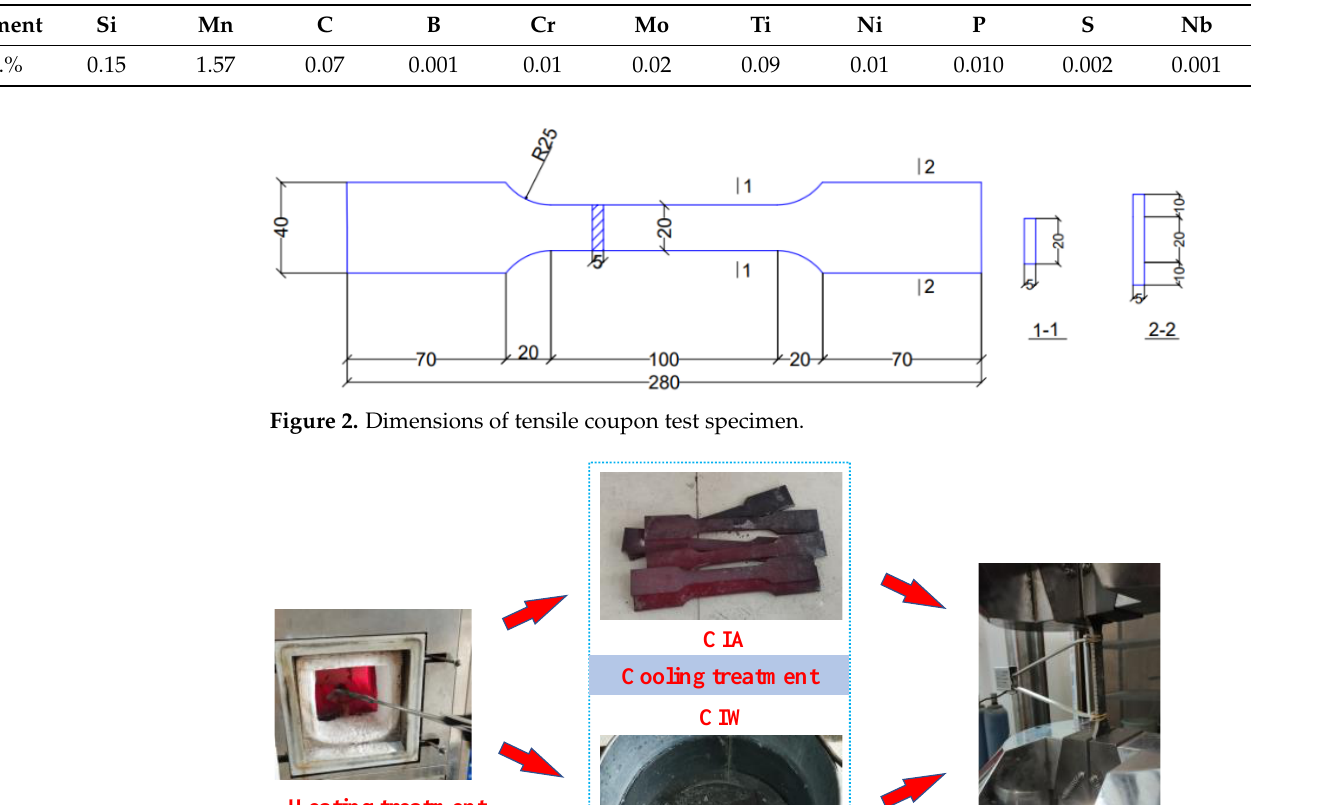
Table 1. Q690 HSS chemical composition.